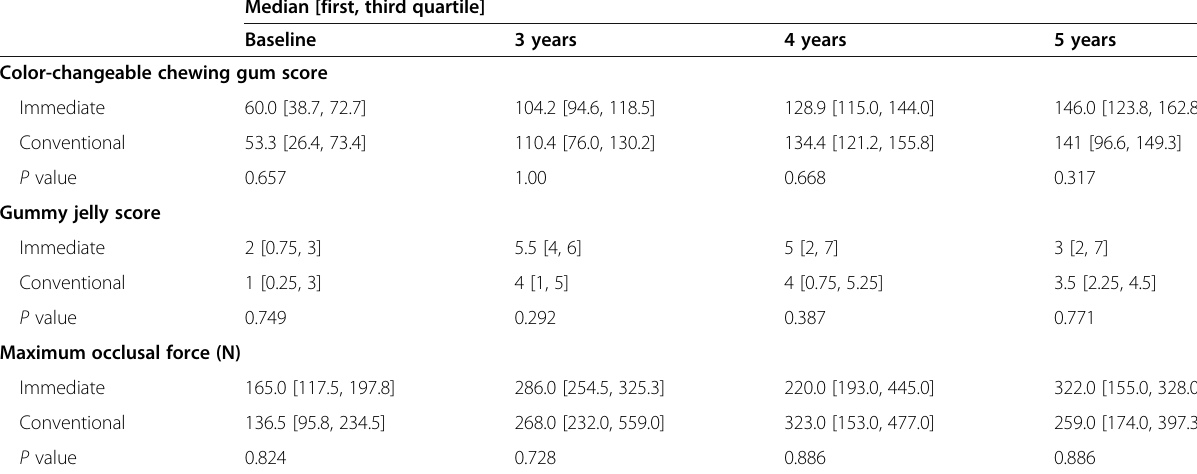
Table 2 Median values for masticatory performance and maximum occlusal force between two loading groups Median [first, third